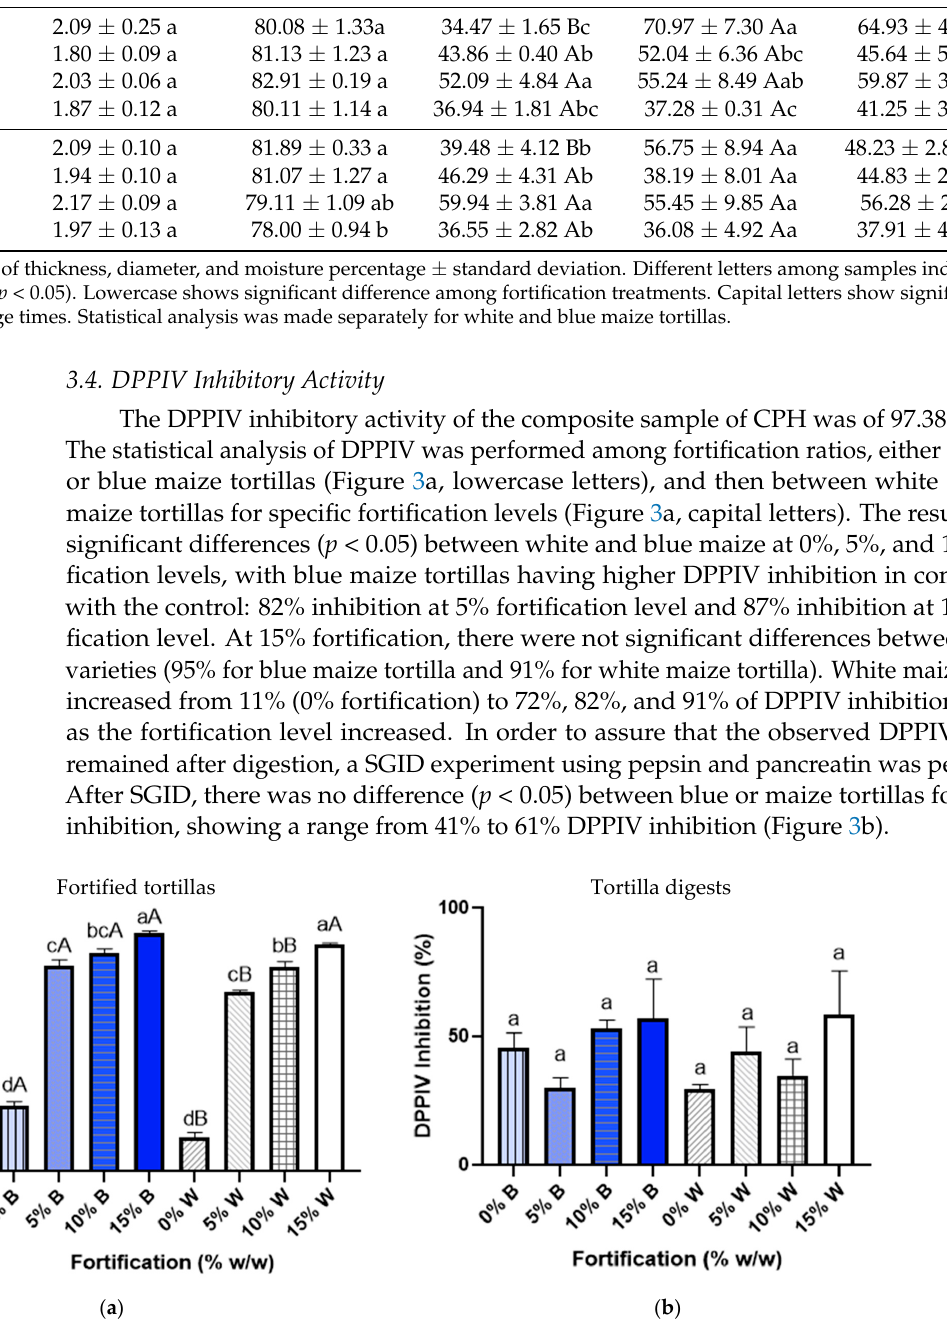
Figure 3. DPPIV inhibition of white and blue tortillas fortified at 0, 5, 10, and 15% with optimized chickpea hydrolysate with DPPIV activity obtained from isolated protein using bromelain. ( a ) Comparison among fortification ratios either for white or blue maize is represented with lowercase letters ( p < 0.05). Comparison between white and blue maize for specific fortification levels is indicated with capital letters ( p < 0.05). ( b ) DPPIV activity after a simulated gastrointestinal digestion (SGID) using pepsin and pancreatin.